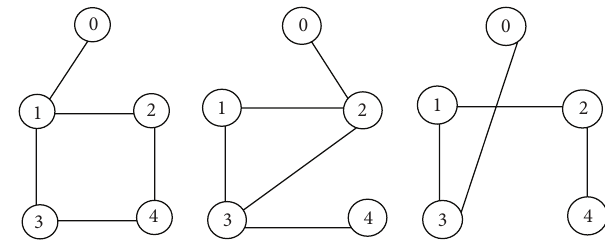
Figure 1: Three interconnection topology